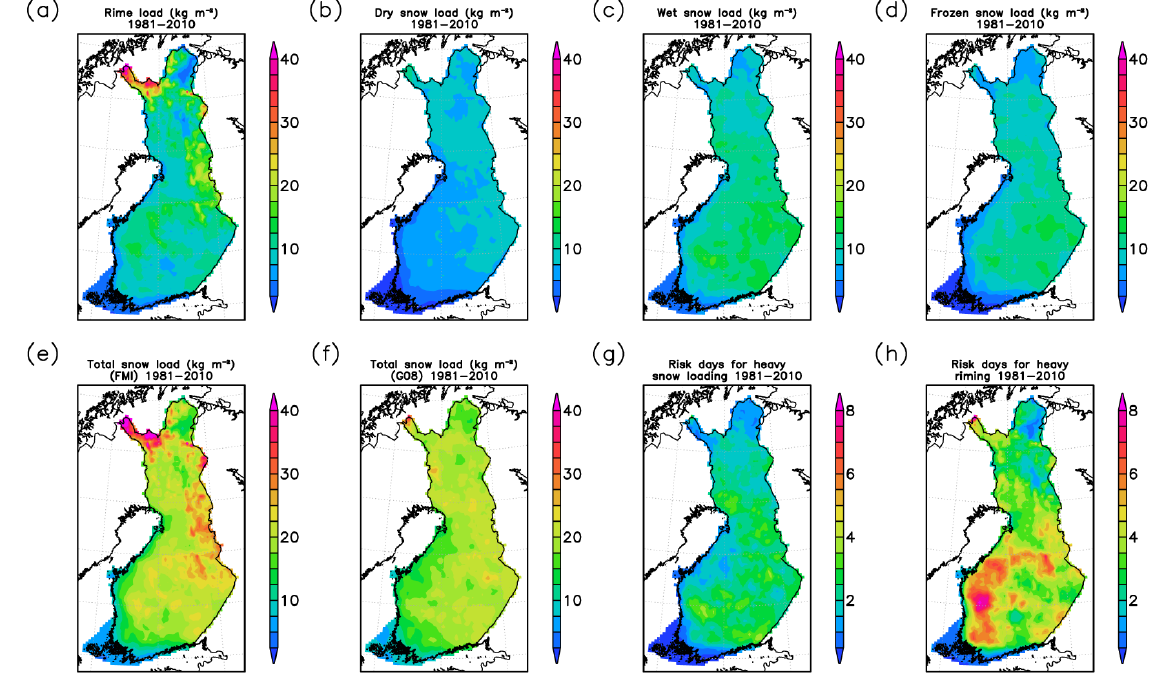
Figure 4. The annual maximum rime loads (a) , dry snow loads (b) , wet snow loads (c) , frozen snow loads (d) , total snow loads based on the FMI method (e) and total snow loads based on the G08 method (f) averaged over the period 1981–2010 and calculated from the observational weather data. The annual numbers of risk days for heavy snow loading (g) and heavy riming (h) are shown as